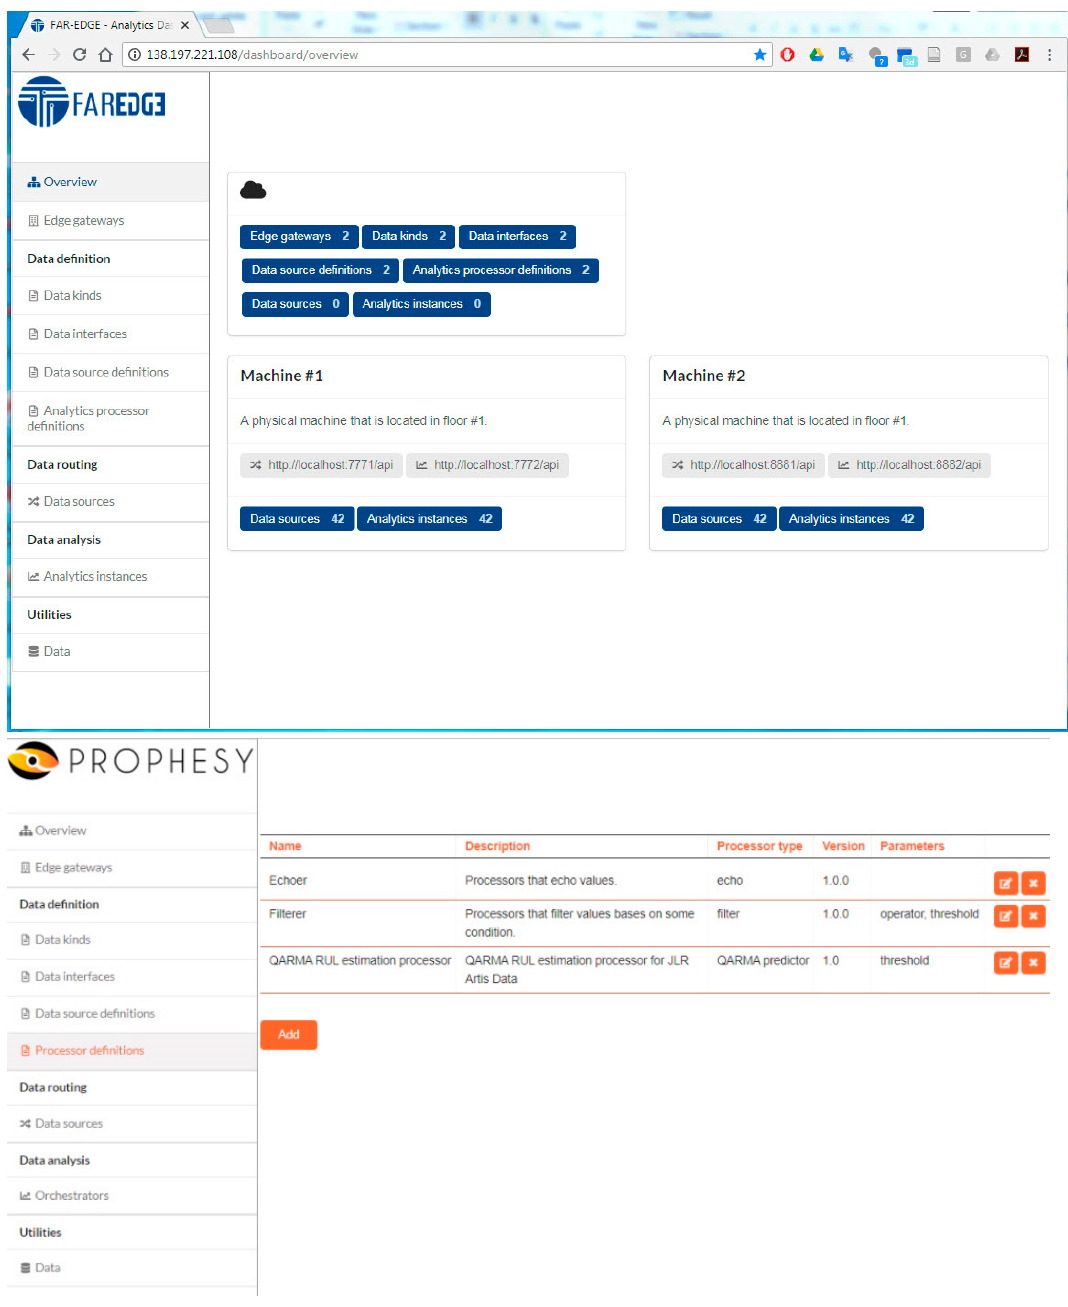
Figure 7. Dashboard for managing the EA-Engine Implementation.